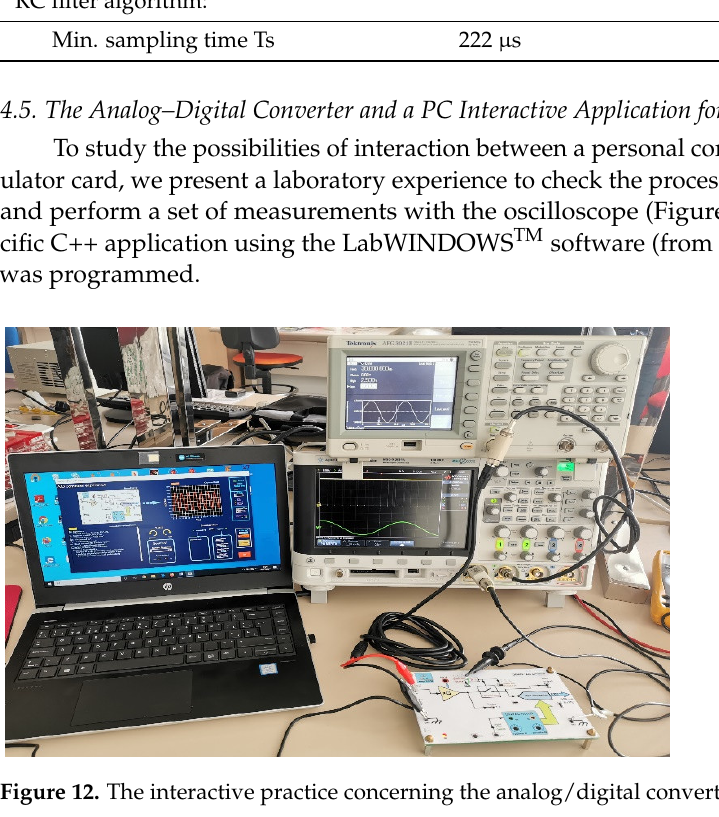
Figure 13. PC application screen for the interactive A/D converter practice.